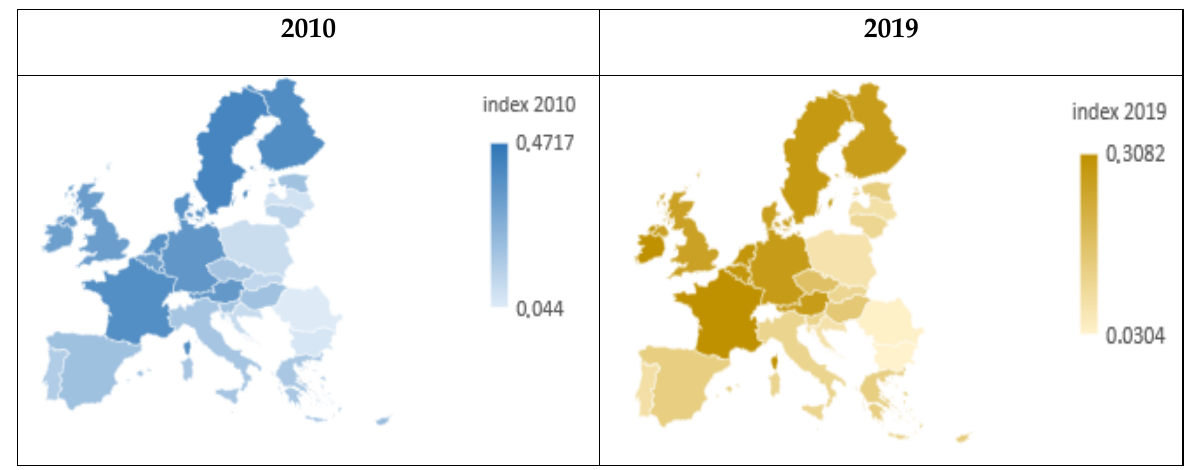
Figure 2. Comparison of the EU countries in terms of the value of the synthetic measure in 2010 and 2019. Source: Authors’ own compilation based on Eurostat data; visualization supported by Bing, Geonames, Microsoft, TomTom.